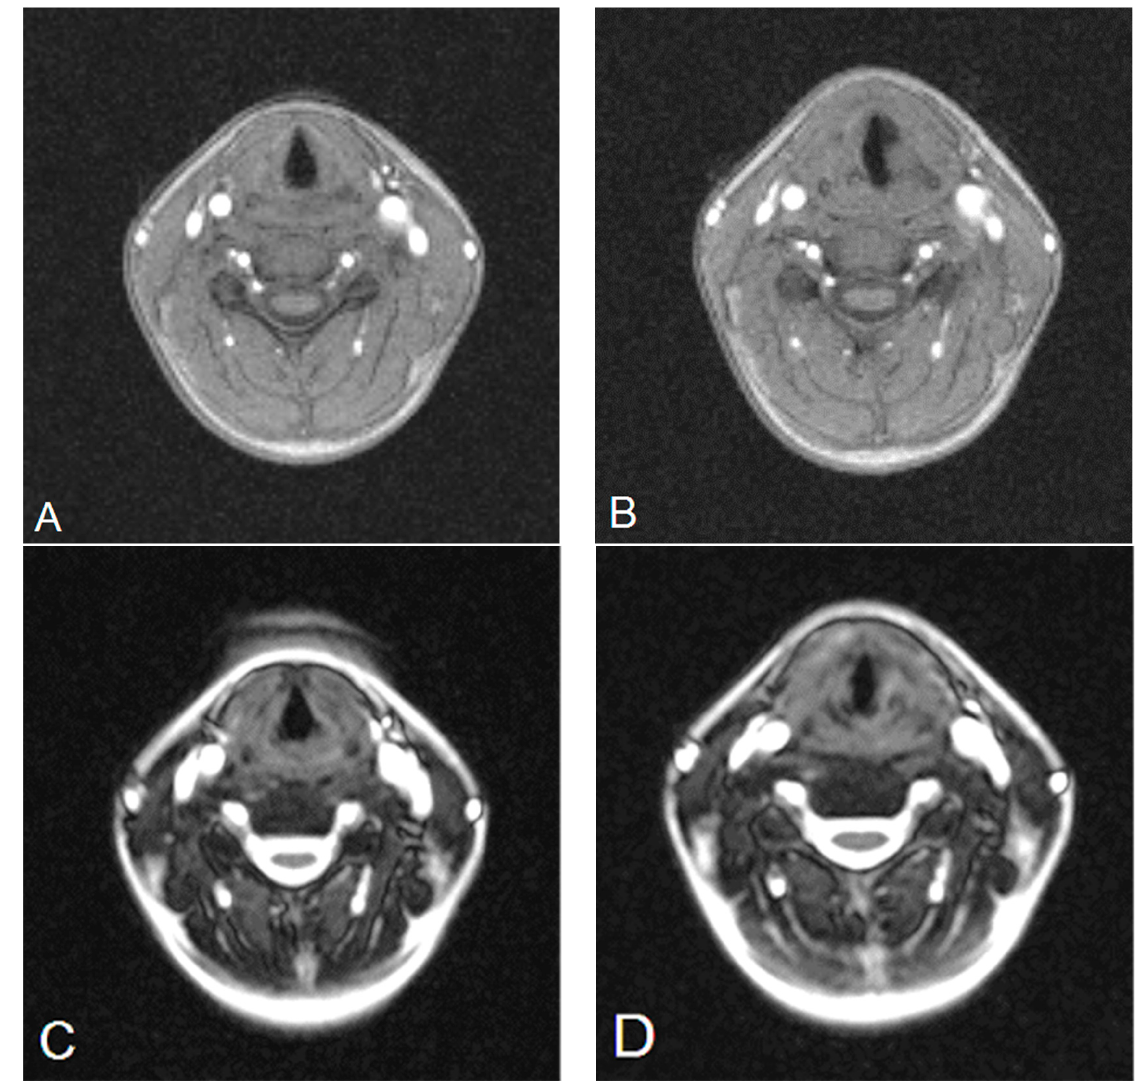
Figure 3. Images of left vocal fold paralysis ( B , D ) compared to preoperative examination ( A , C ). MRI-GRE ( A , B ), MRI-TRUFI ( C , D ).